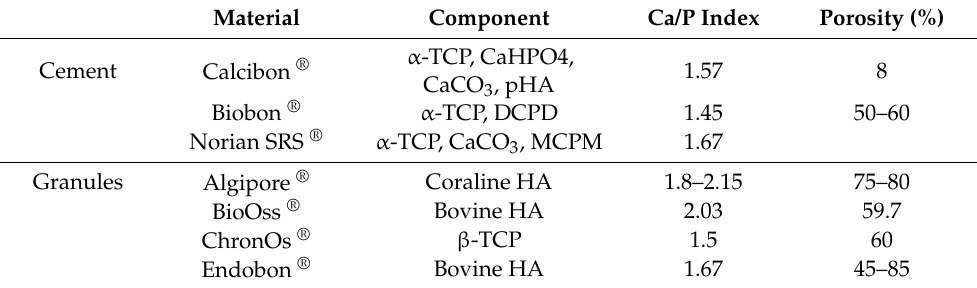
Table 2. Material properties of the different used bone graft substitutes modified from